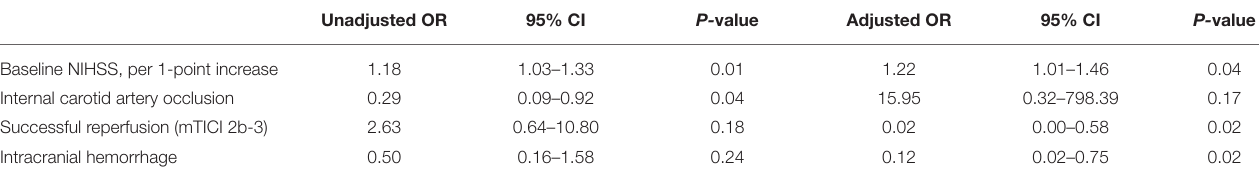
TABLE 5 | Logistic regression analysis of factors associated with mortality.